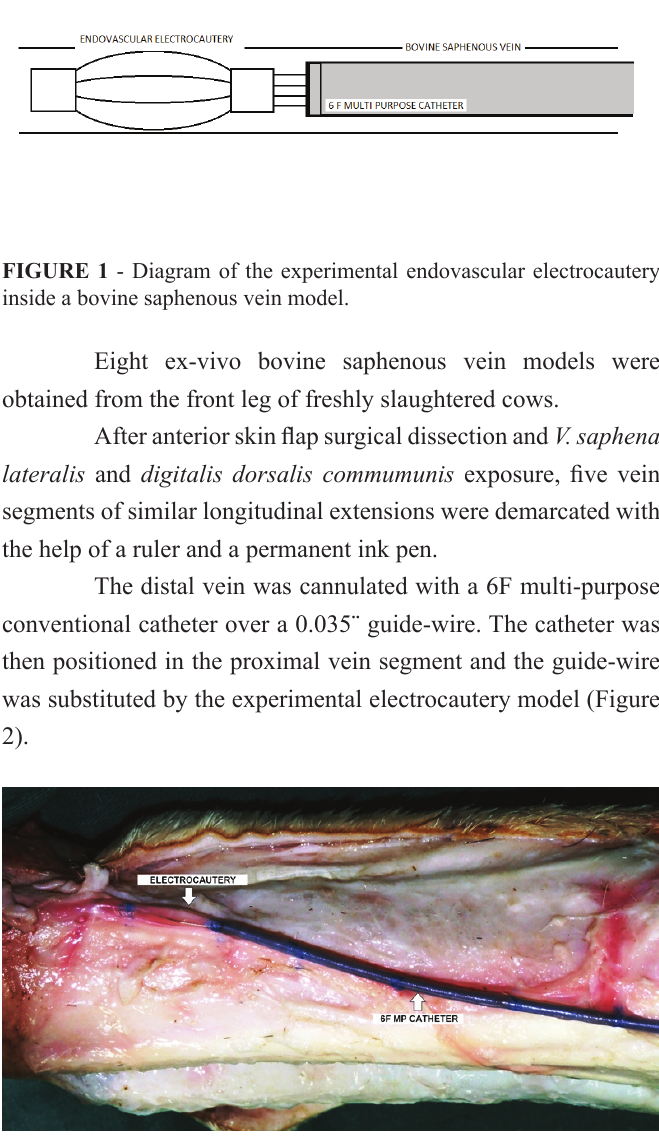
FIGuRE 2 - Experimental electrocautery exposed at the proximal saphenous bovine vein. It was previous demarcated in five segments of similar longitudinal